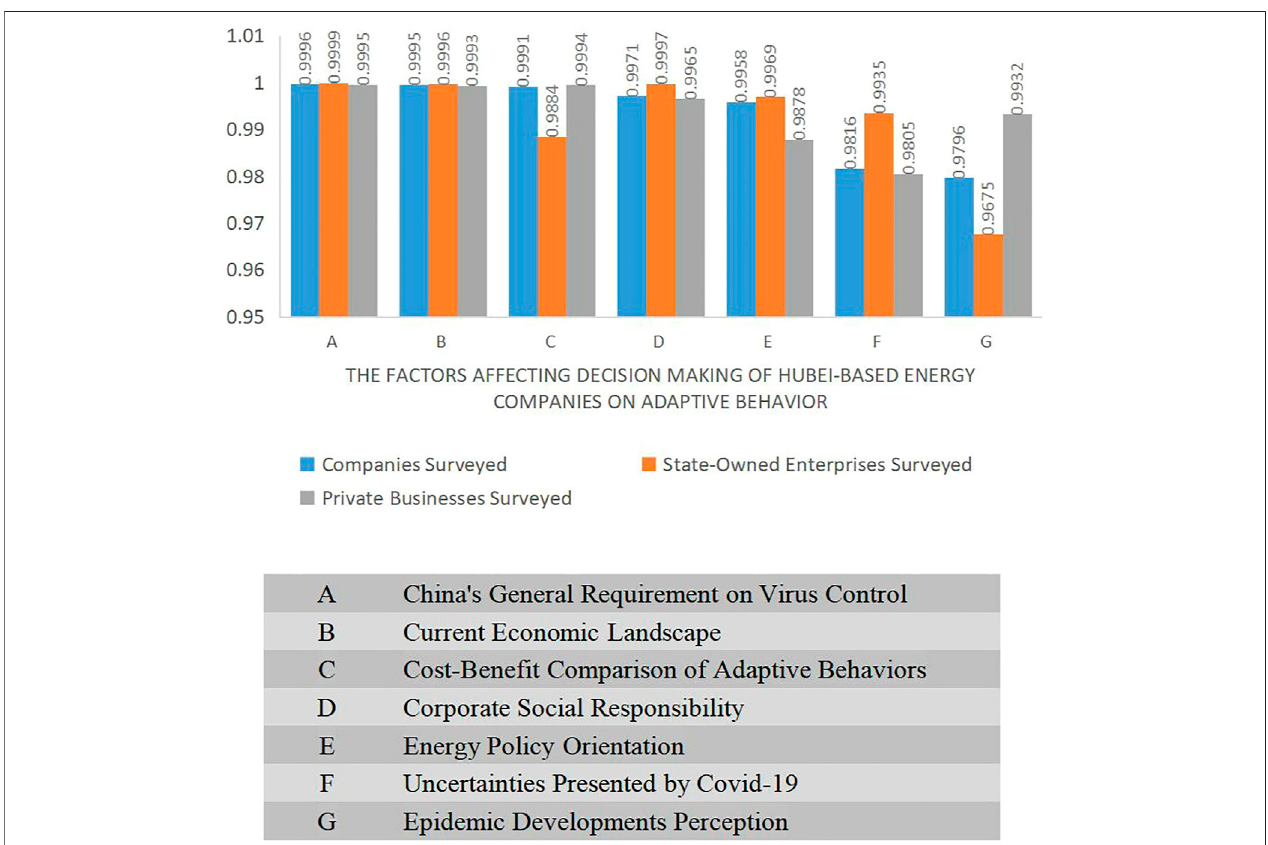
FIGURE 2 | The comparison diagram on the criticality of key factors affecting decision making on the adaptive behaviors of all respondents, state-owned companies, and private businesses.